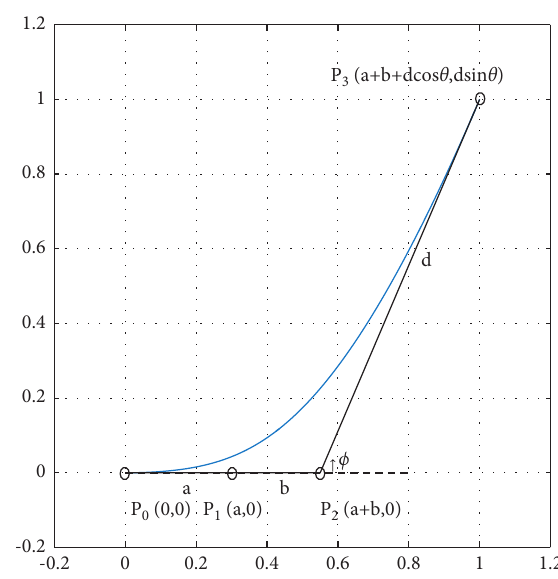
Figure 9: Representation of ellipse using the CT-B´ezier curve.